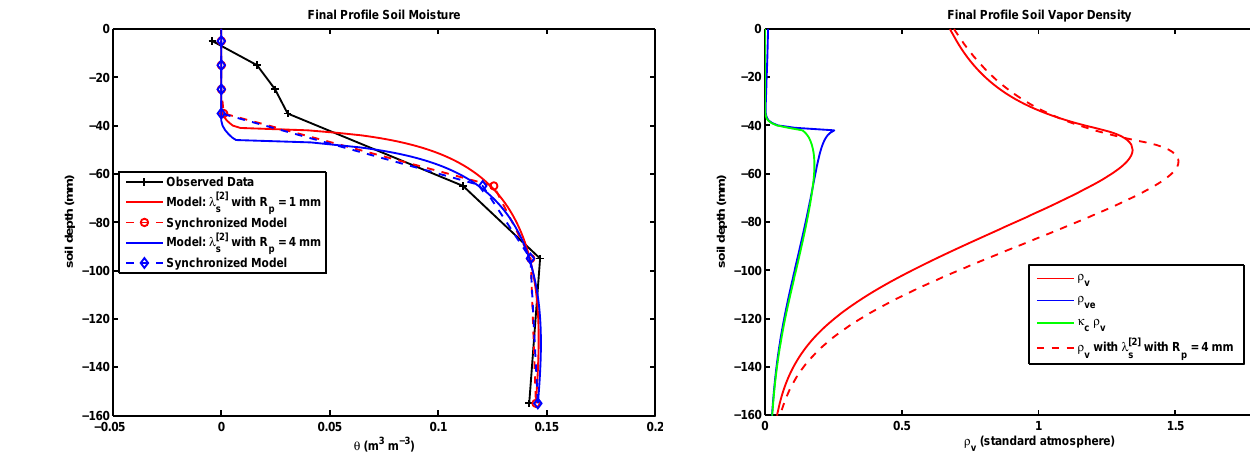
Figure 6. Comparison of the final modeled and measured mois- ture profiles at the completion of the Quincy Sand heating experi- ment. Because the data shown in the measured profile (black) are not precisely coincident in time, the full model results (solid red and blue lines) were sub-sampled in synchrony in time (and co- incide in space) with the observations. These synchronized model profiles are shown as dashed red and blue lines. The observed data (black) suggest that the total water lost during the 90min experi- ment was 31% of the initial amount. The (red) model simulation indicated a 31.4% loss and the corresponding (red) synchronized model yielded a 33.8% loss. The (blue) model simulation indicated a 34.6% loss and the corresponding (blue) synchronized model yielded a 34.2% loss. Note there is very little recondensing soil moisture ahead of the drying front (at about 40–50mm depth), in agreement with Figs. 2 and 4 above and in contrast with the equilib- rium model, Fig. 7 of Massman (2012), where there was significant recondensation.